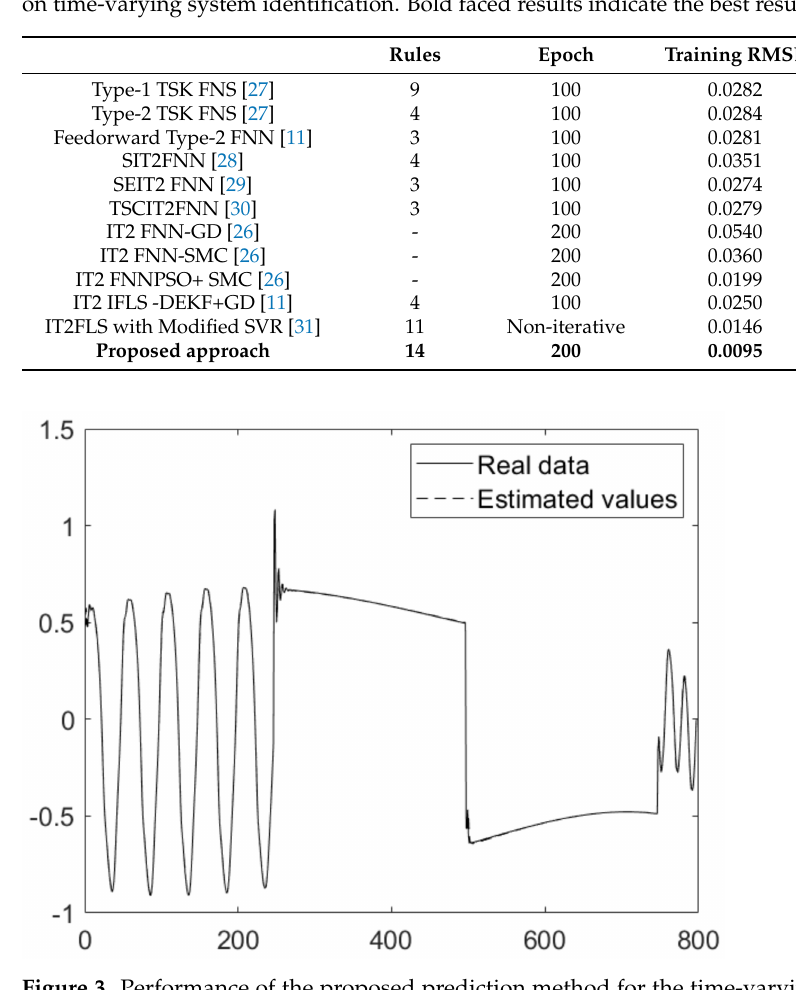
Figure 3. Performance of the proposed prediction method for the time-varying nonlinear system dataset (train set).